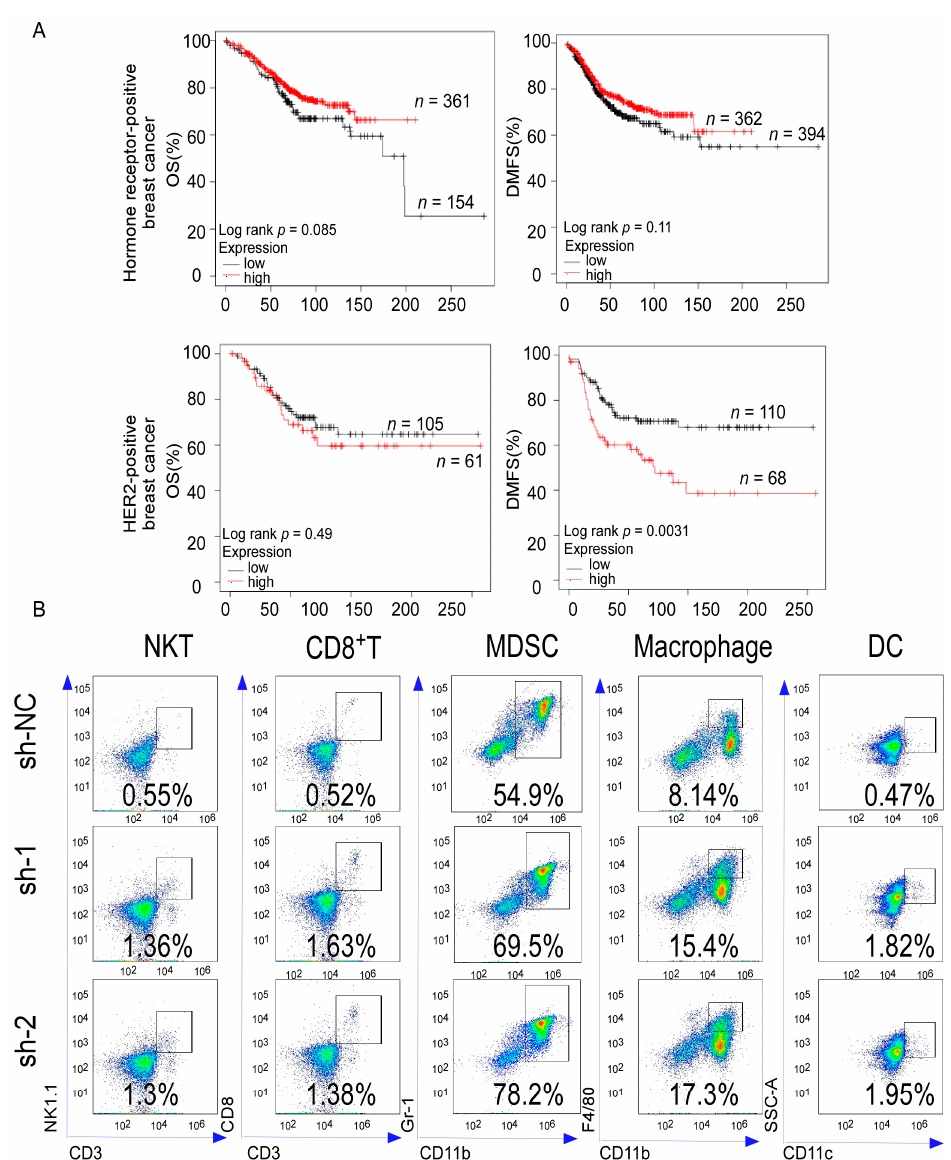
Figure A1. ( A ) Kaplan–Meier analysis of the correlation between CTNND1 expression and overall survival (OS), distant metastasis-free survival (DMFS) in other types of breast cancer (hormone re- ceptor-positive breast cancer and HER2-positive breast cancer). ( B ) The infiltration of immune cells in the bone of mice with EO771 cells that had downregulated expressing of CTNND1 (EO771 CTNND1KD )). All experiments were repeated at least 3 times. Error bars indicate Standard Error of Mean (S.E.M.).